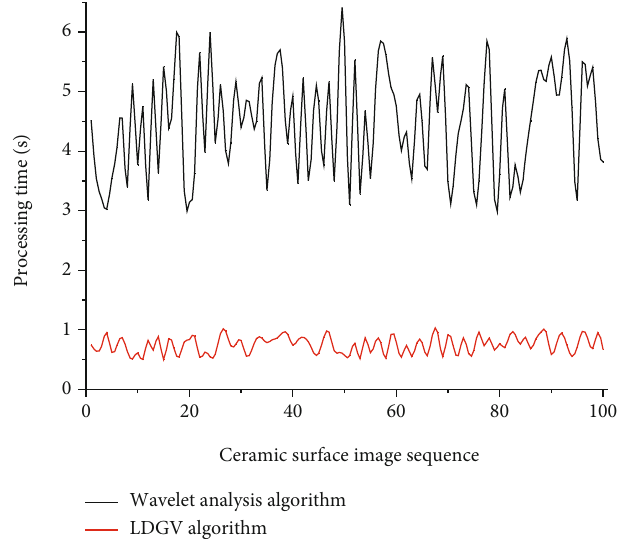
Figure 4: Running time of magnetic ring inner wall inspection for both methods.